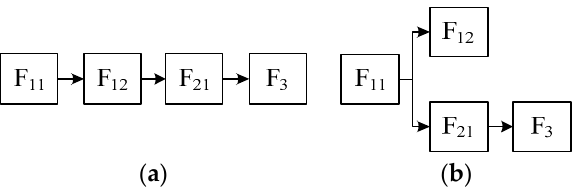
Figure 3. Two forms of the function chain [53]. ( a ) serial function chain; ( b ) parallel function chain.